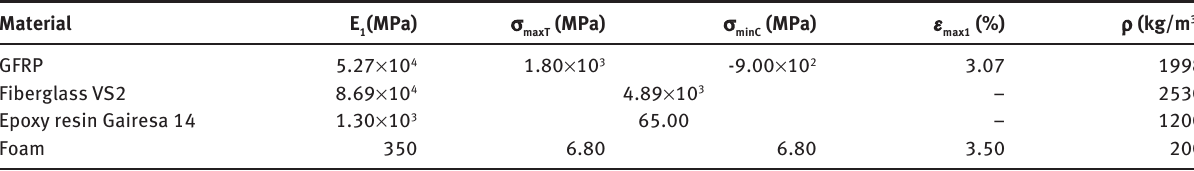
E (MPa), elastic modulus or Young’s modulus; σ 1 maximum elongation; ρ (kg/m 3 ),